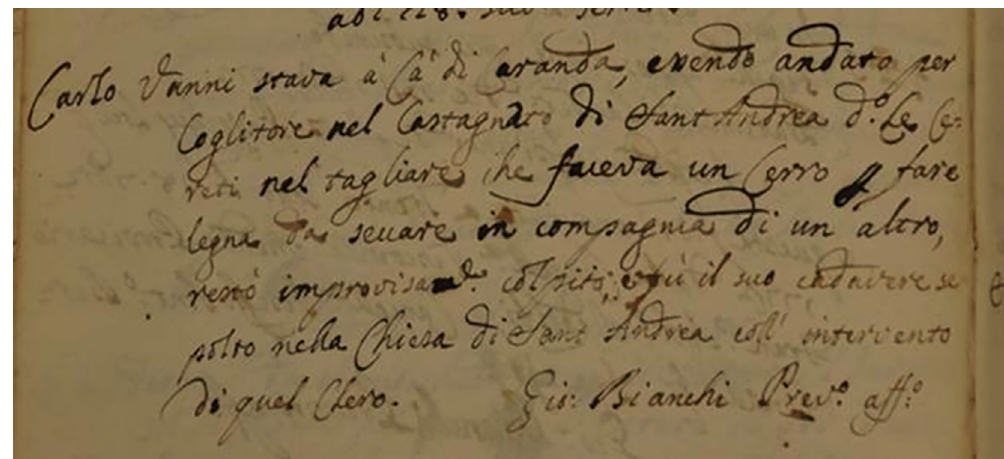
Fig 11. Fragment of the ancient parish records in ancient Italian language: February 28 1773, Carlo Vanni ( ... ) chopping ( ... ) old oak wood making firewood to burn together, he was suddenly struck (the original Italian text: “ 28 Febbraio 1773 ... nel tagliare ... un cerro per fare legna da seccare in compagnia ... resto improvvisamente colpito) (c).